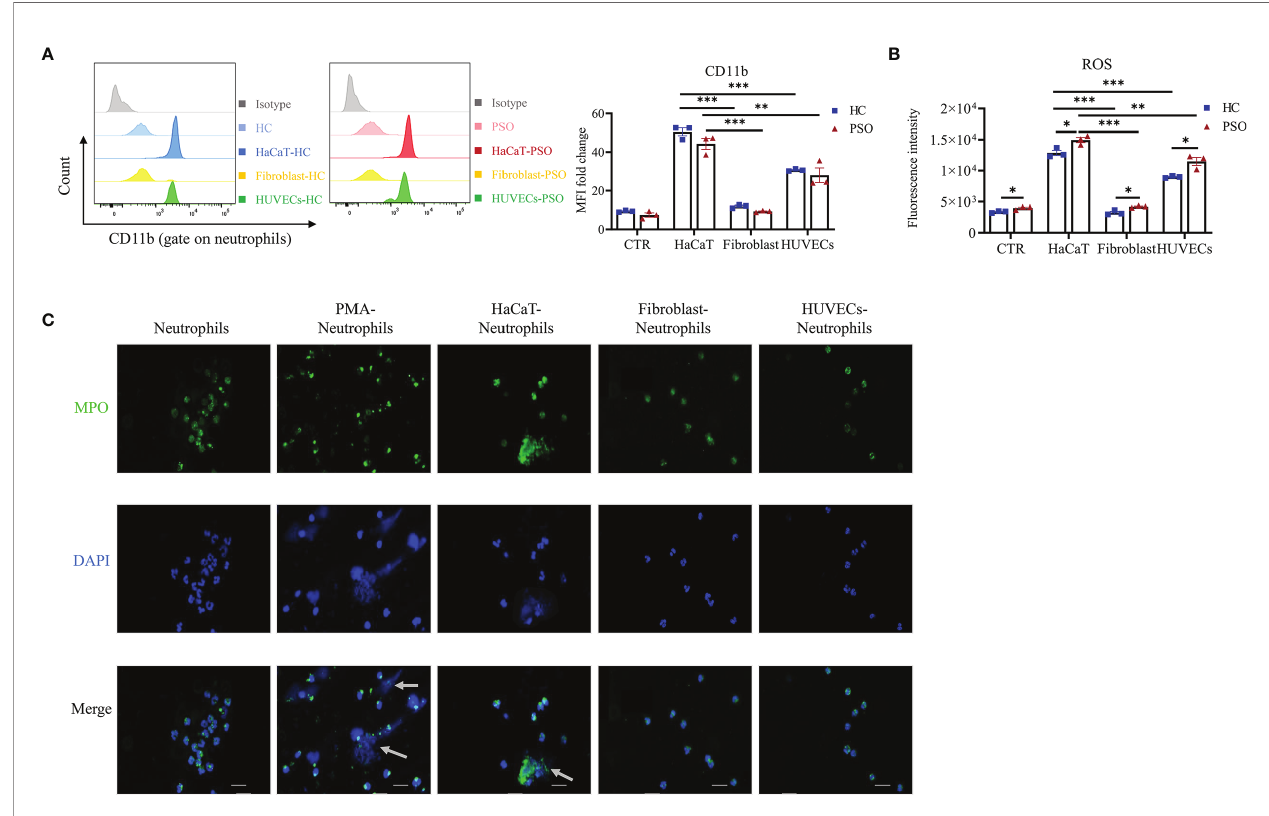
FIGURE 5 | Neutrophils are particularly activated by keratinocytes. (A, B) Representative graph and quanti fi cation of CD11b expression (A) and ROS (B) in neutrophils stimulated by HaCaT, fi broblast and HUVEC. (C) Representative immuno fl uorescence staining for MPO (green), DAPI (blue) and merged images of neutrophils stimulated by vehicle, PMA (100 nmol/ml, positive control), HaCaT, fi broblasts and HUVECs, respectively. Scales bar = 20 µm. White arrow indicates NETs. Data are representative of three or more independent experiments. Data are presented as mean ± SEM, analyzed by one-way ANOVA. *p < 0.05; **p < 0.01; ***p < 0.001. HUVEC, human umbilical vein endothelial cells; NETs, neutrophil extracellular traps; ROS, reactive oxygen